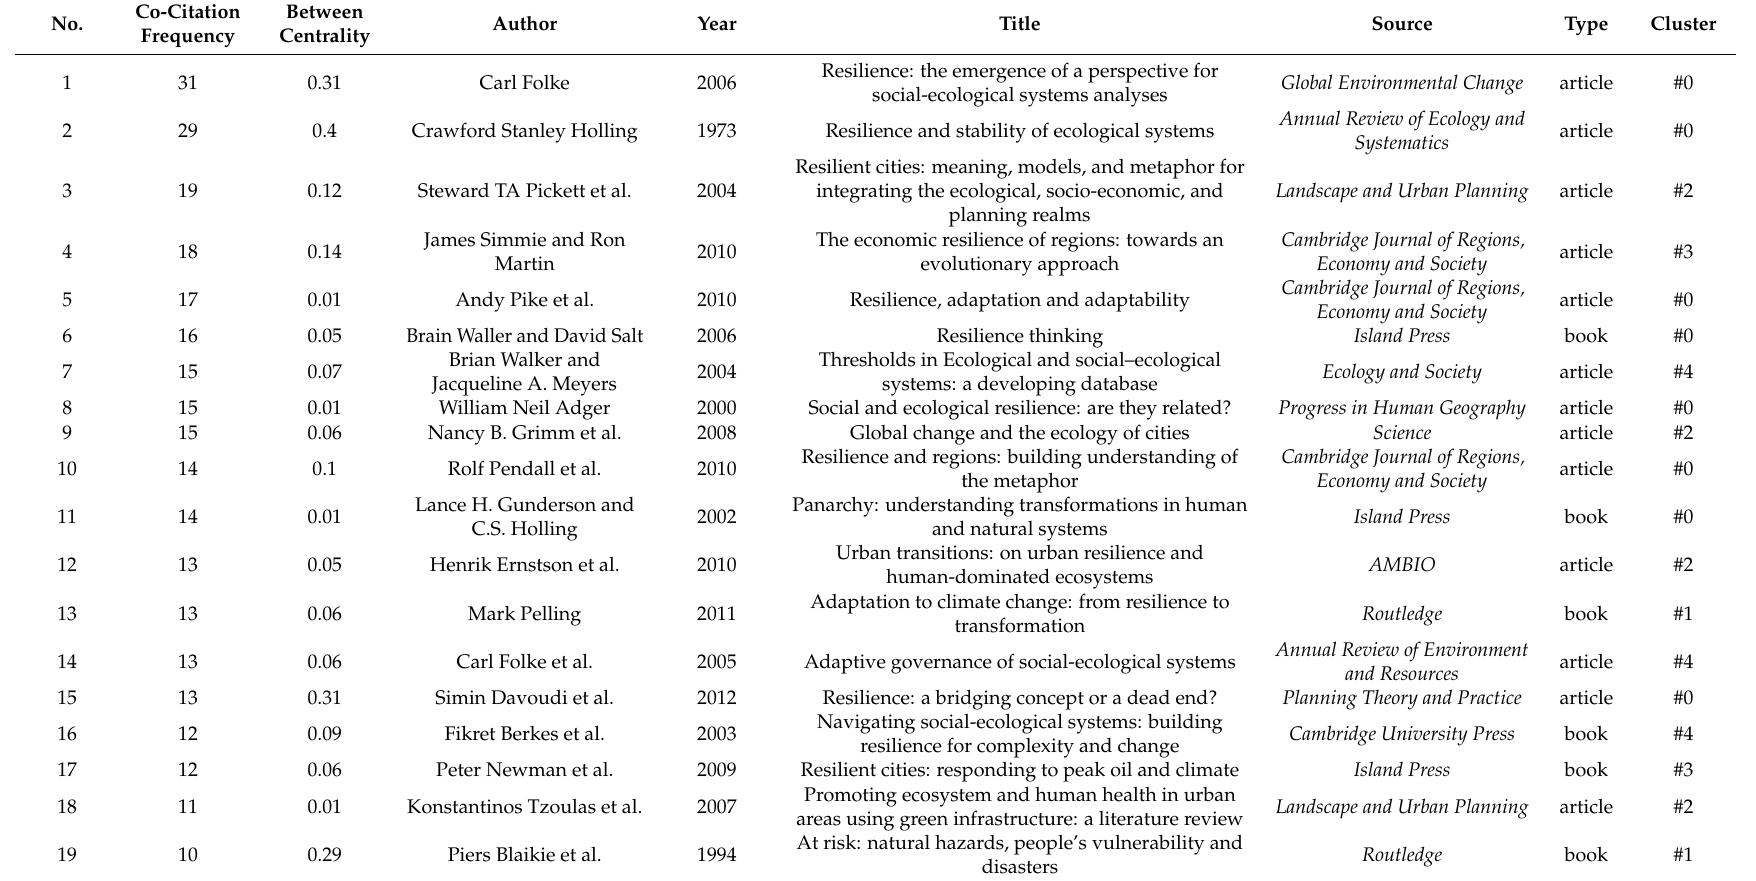
Table 6. The top 19 co-cited documents in document co-citation